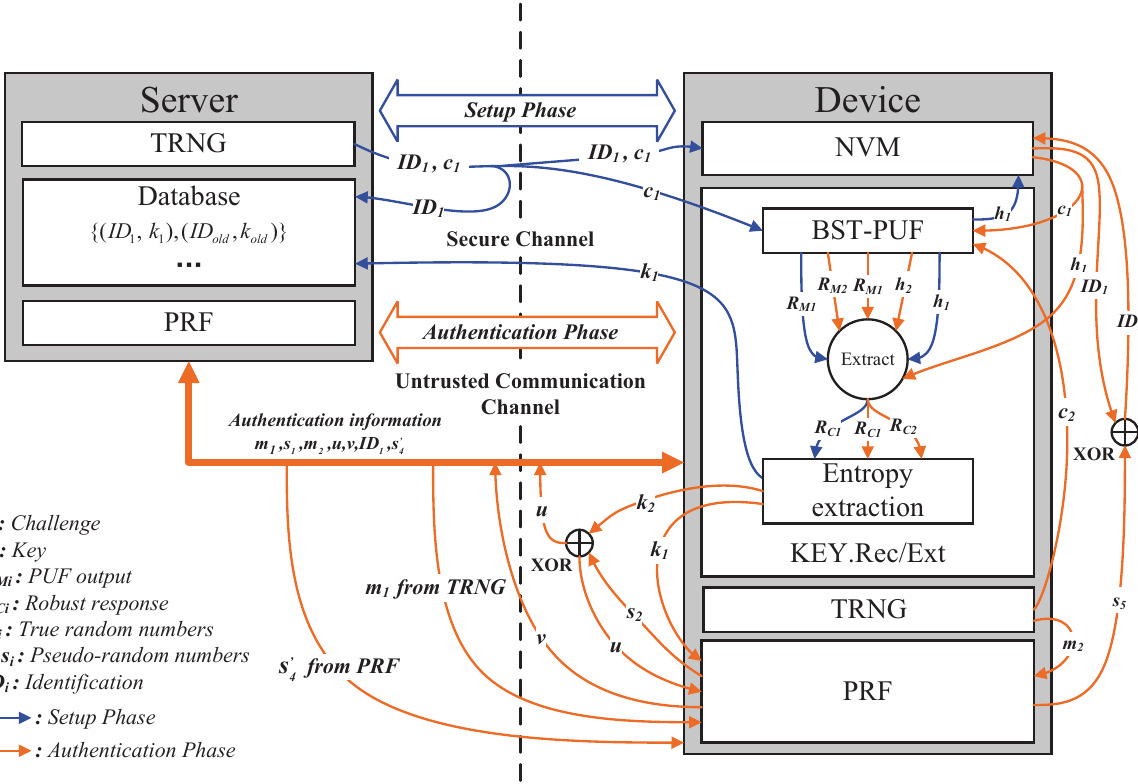
Figure 1. The schematic diagram process of the proposed